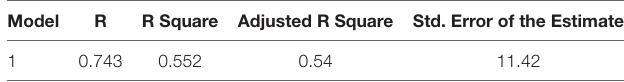
TABLE 6 | Model summary for WE, SE, and CE. Model